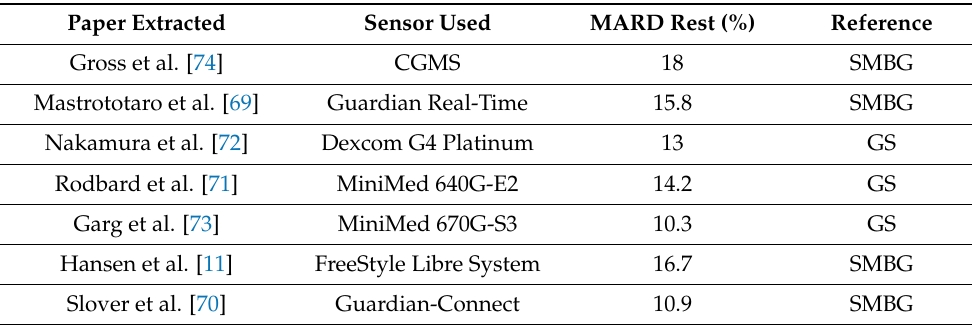
Table 2. Reported MARD data for resting periods for the sensors that the studies in Table 1 did not originally